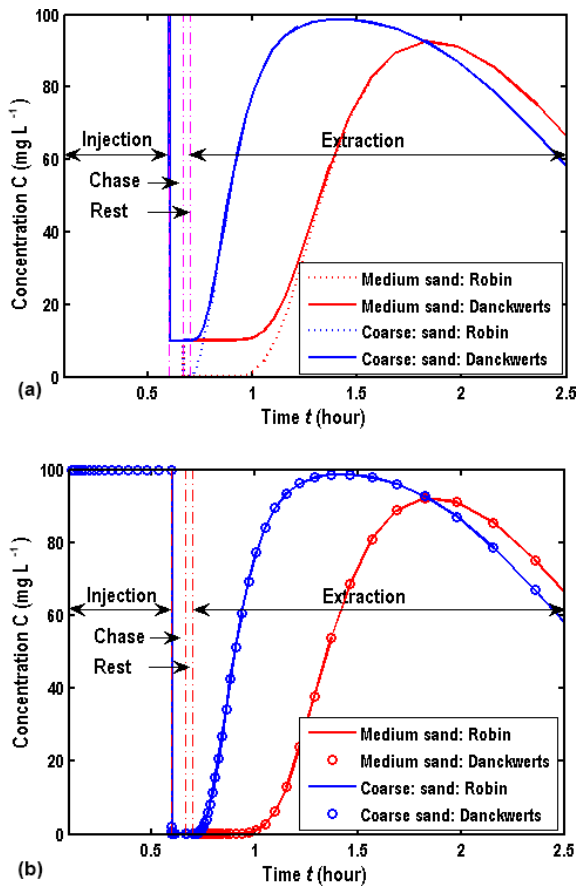
Figure 4. Comparison of BTCs in the wellbore between the Robin and Danckwerts conditions: (a) C cha